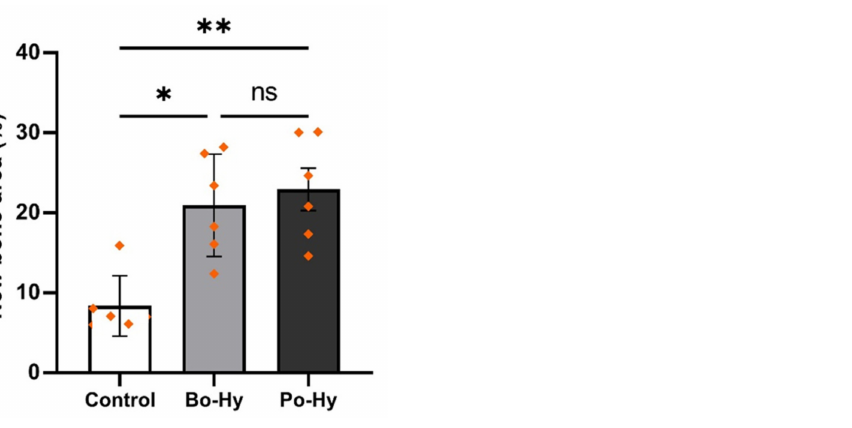
Figure 13. The percentage of new bone area determined by histological analysis (ns: non-significant, *: p < 0.05, **: p < 0.01). Differences between the two xenograft groups were not statistically significant. Table 4. Histology analysis results of new bone area for all samples at 8